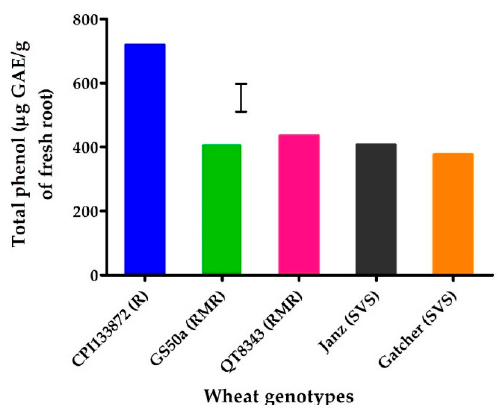
Figure 2. Total phenols ( µ g gallic acid equivalent (GAE) / g of fresh root) at 3 weeks in the roots of resistant wheat genotypes—CPI133872 (blue), GS50a (green), and QT8343 (red)—and susceptible wheat genotypes—Janz (black) and Gatcher (orange)—grown on agar in gnotobiotic conditions. The values are the means of three replicates. The bar marker indicates LSD = 84 ( p = 0.05). The Pratylenchus thornei resistance rating of each wheat genotype is shown in parenthesis—R = resistant, MR = moderately resistant, S = susceptible, and VS = very susceptible.